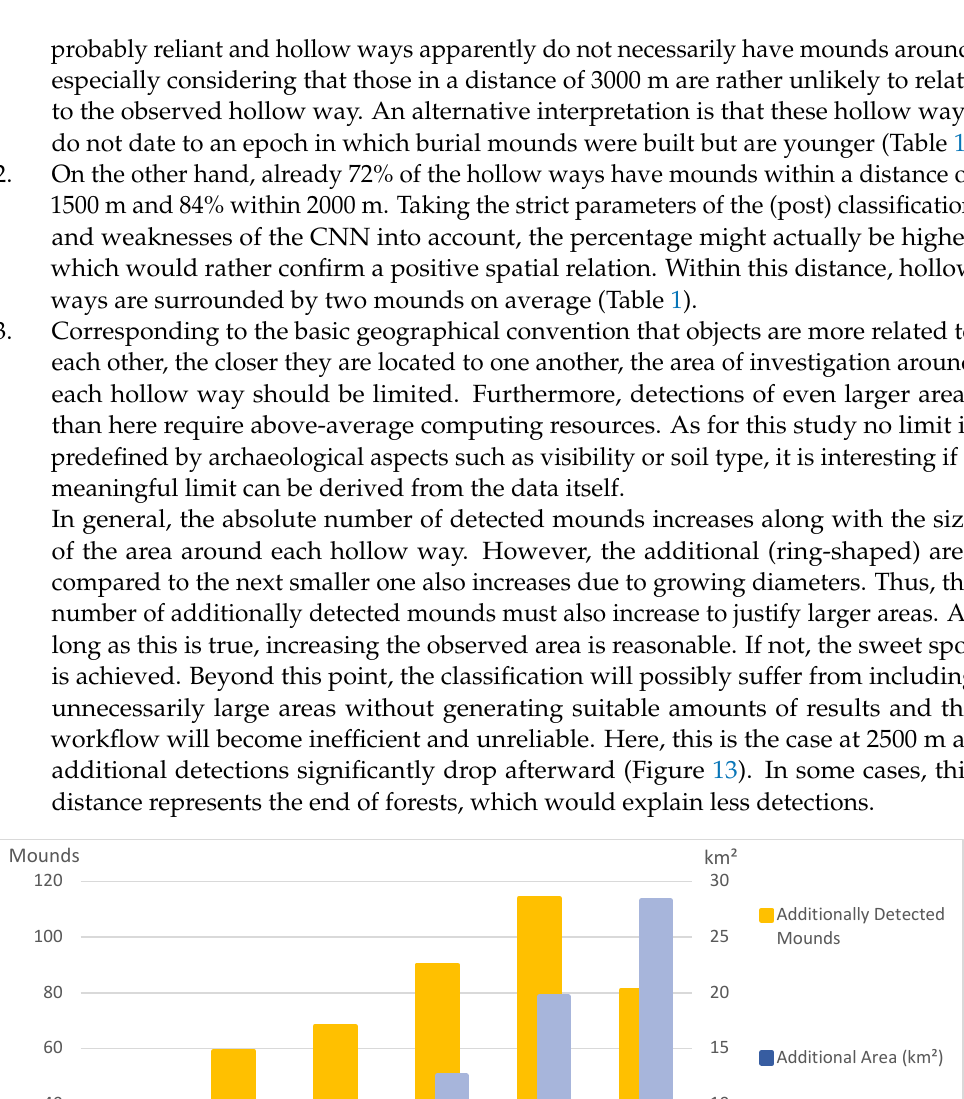
Figure 14. Maximum number of mounds of each hollow way in dependency on the radius. 5.